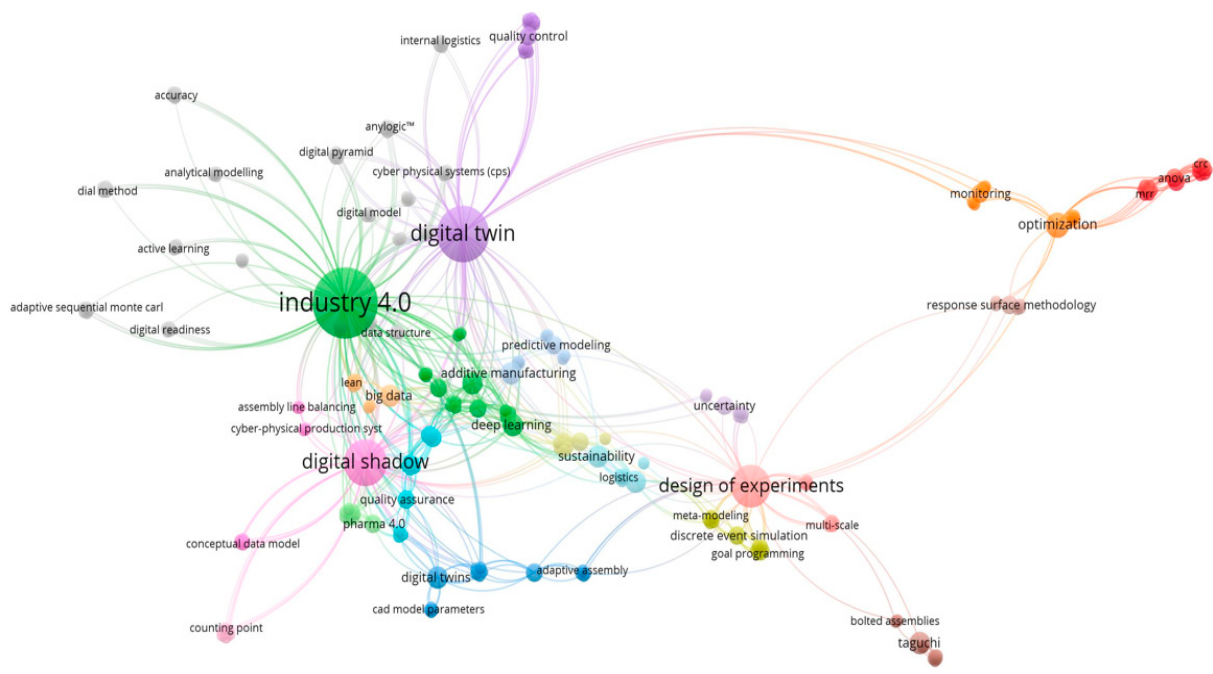
Figure 1. Network Visualization of Literacy Topic Area.